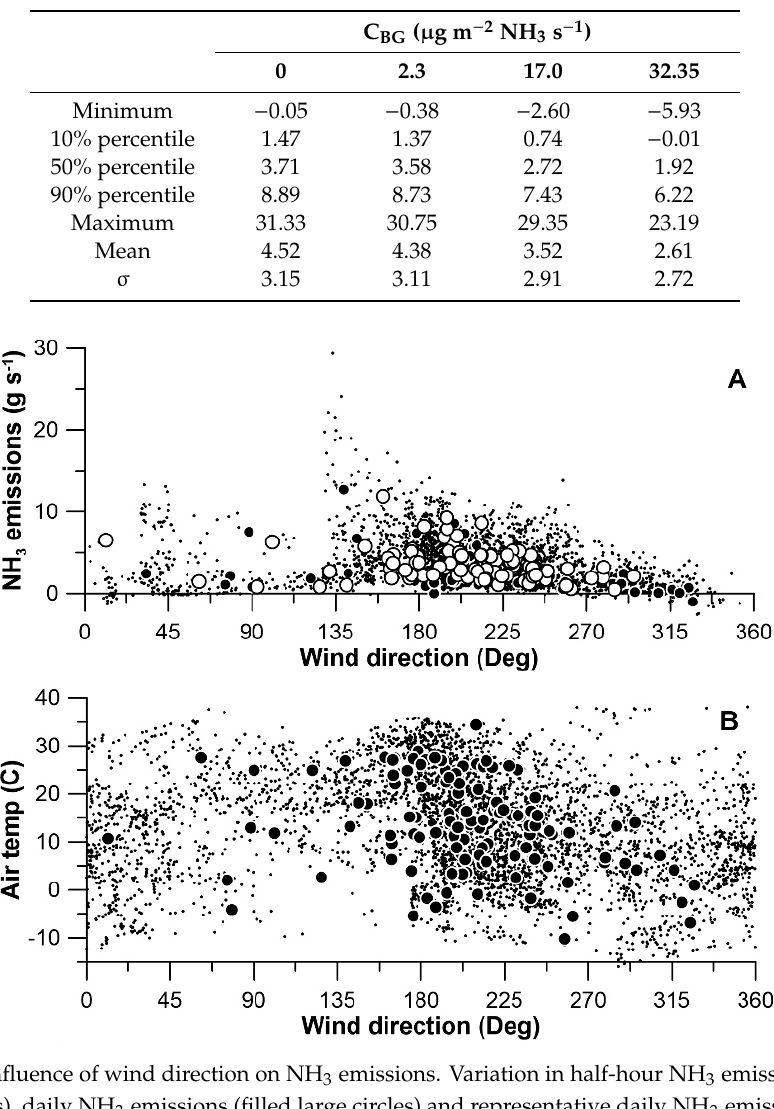
Table 5. Influence of assumed background NH 3 concentration on emissions.